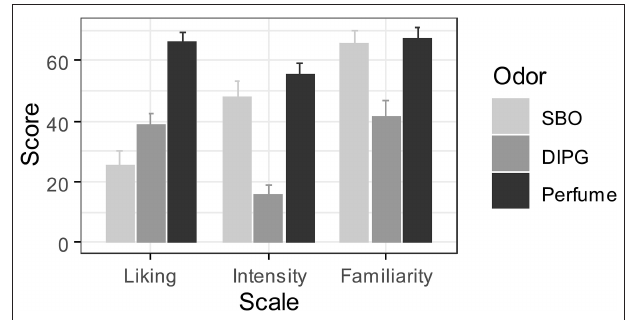
FIGURE 4 | Results on liking, intensity, and familiarity scales on Perfume, SBO, and